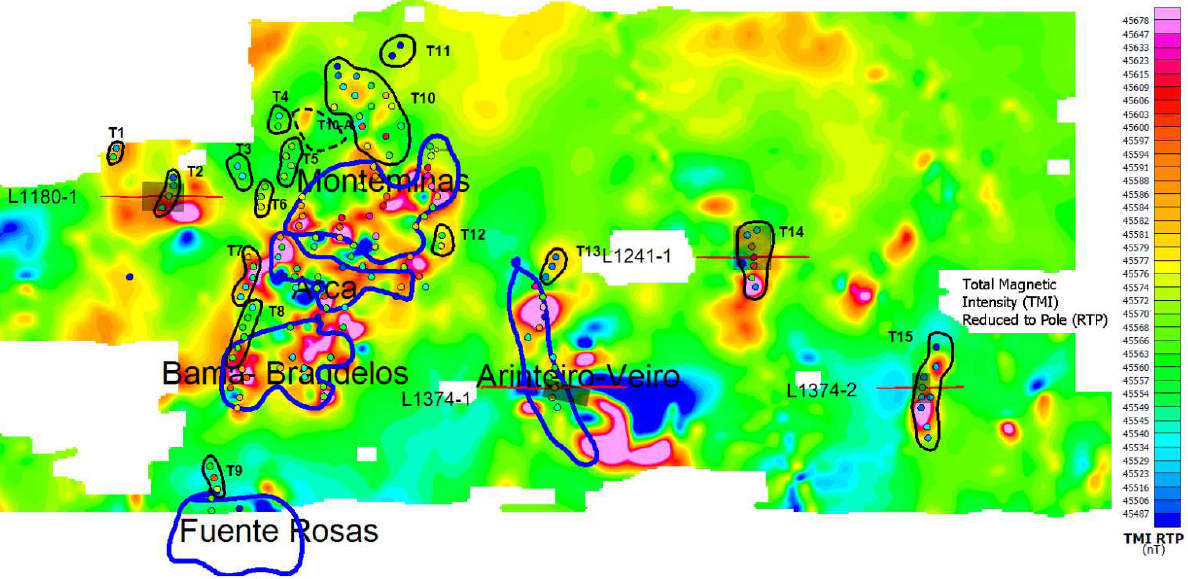
Figure 7. Total field magnetic colour image, known ore bodies (blue outlines), and colour dots with values > 20 Siemens. VTEM sections modelled in Maxwell ElectroMagnetic Imaging Technology (red horizontal line) with plates in Figures 8–11.